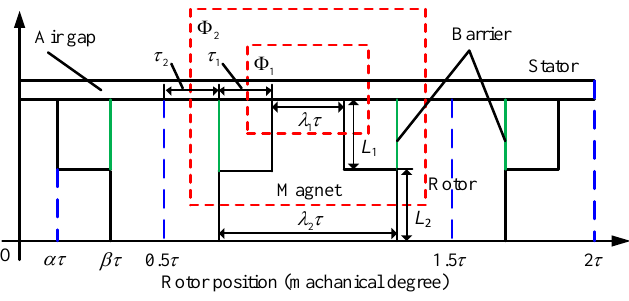
Figure 7. Main paths of the magnetic flux of the machine at no-load.